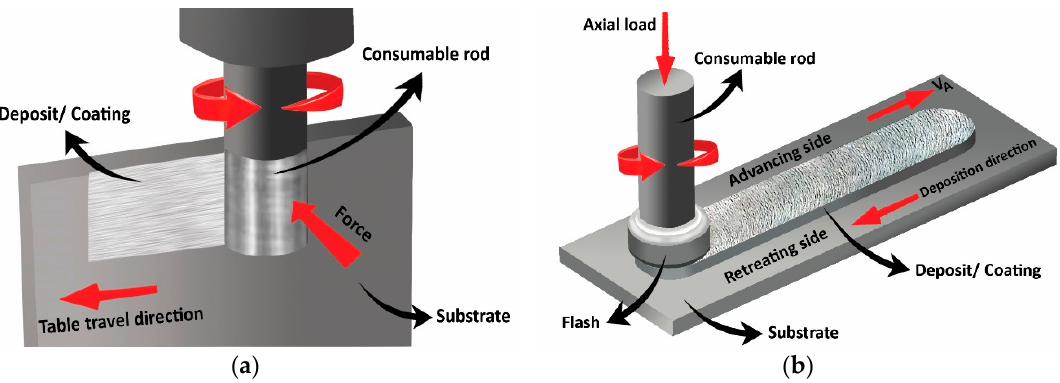
Figure 1. Friction surfacing deposition: ( a ) from the side of the tool, ( b ) from the end of the tool.